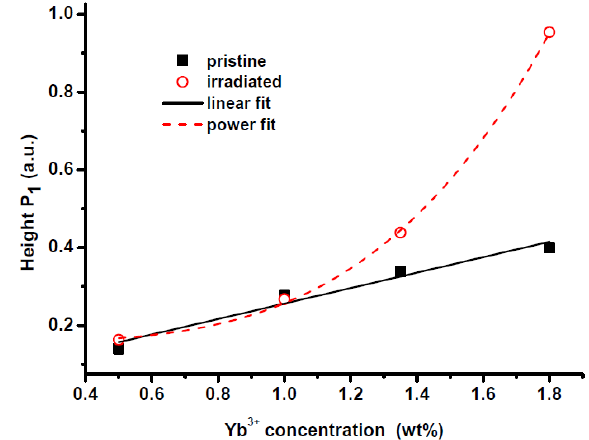
Figure 4. Height of the P1 peak versus Yb 3+ ions